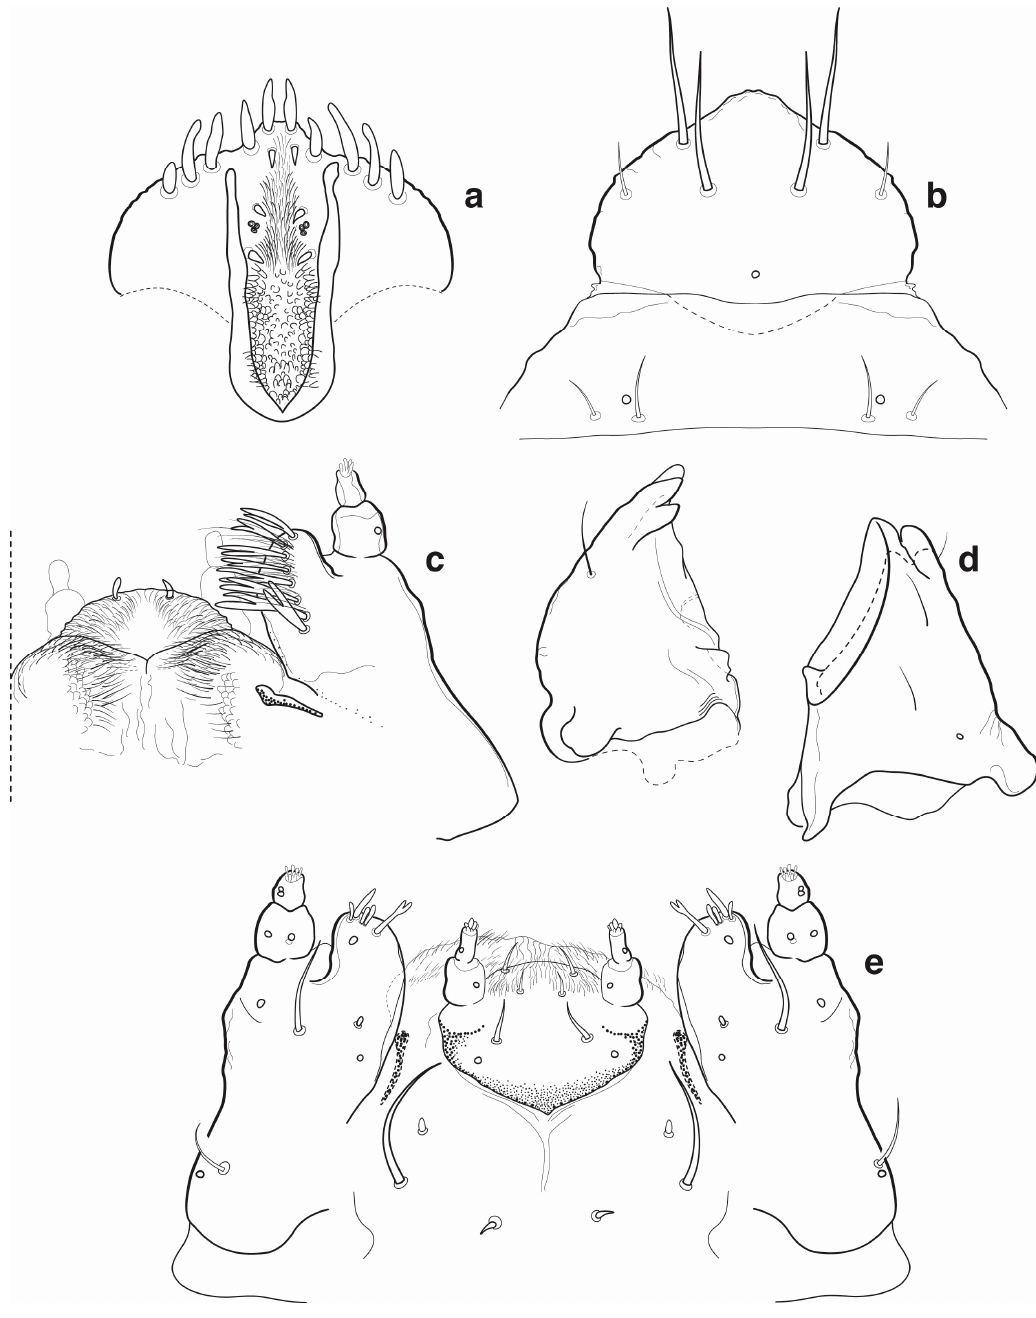
Figure 74. Polytus mellerborgii mouthparts: ( a ) epipharynx; ( b ) clypeus and labrum; ( c ) maxillae and hypopharynx, dorsal view; ( d ) mandibles; and ( e ) labio-maxillary complex, ventral view.